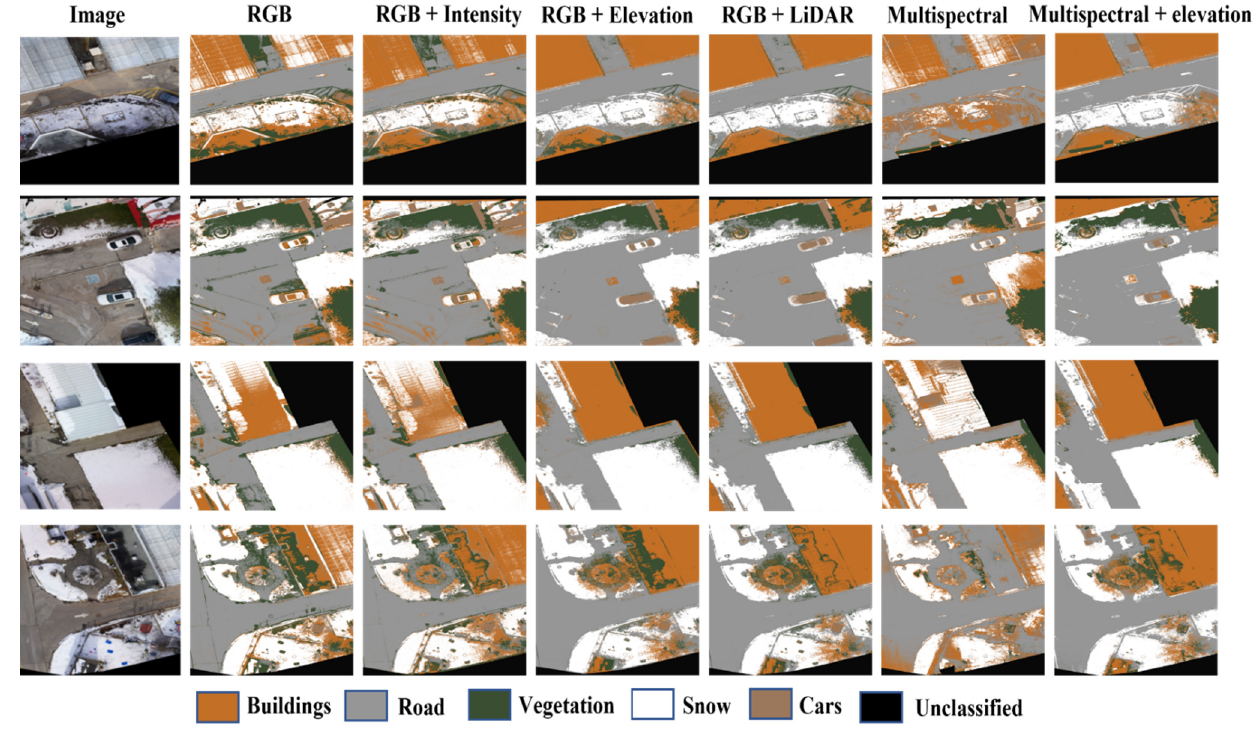
Figure 19. Classification results using the maximum likelihood technique. Table 1. Classification results of the six combinations using the maximum likelihood technique.